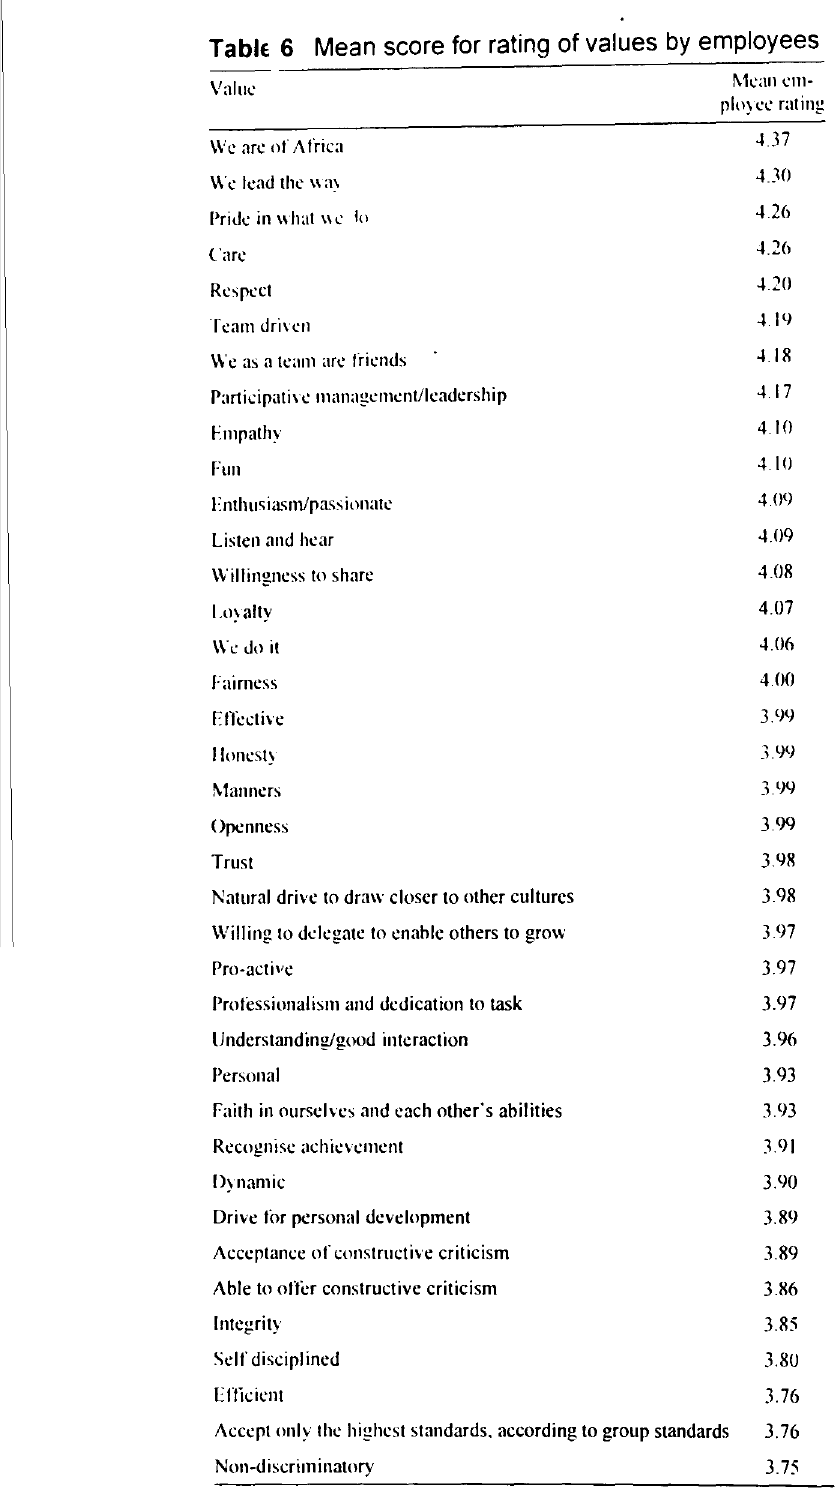
Table 11 indi<.:atcs the boltom lL'11 , ,illlL:, "' 1;111~L·d hy em ployees and